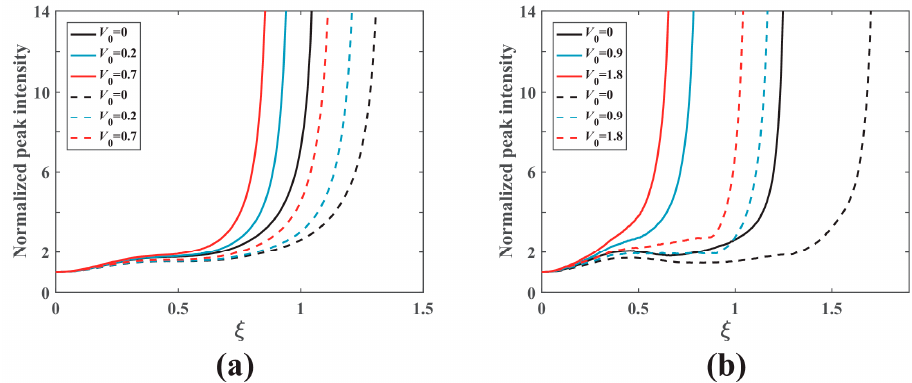
Figure 3. The normalized peak intensity of vortex beams with d = 0.23 in a Kerr–ROLP medium for different modulation depths as a function of transmission length. ( a ) n = 1 with different initial powers: P in = 6.46 P G (i.e., 1.7 P cr for V 0 = 0.2 (solid lines)); P in = 5.61 P G (i.e., 1.7 P cr for V 0 = 0.7 (dashed lines)). ( b ) n = 2 with different initial powers: P in = 9.52 P G (i.e., 1.4 P cr for V 0 = 0.9 (solid lines)); P in = 7.83 P G (i.e., 1.4 P cr for V 0 = 1.8 (dashed lines)).